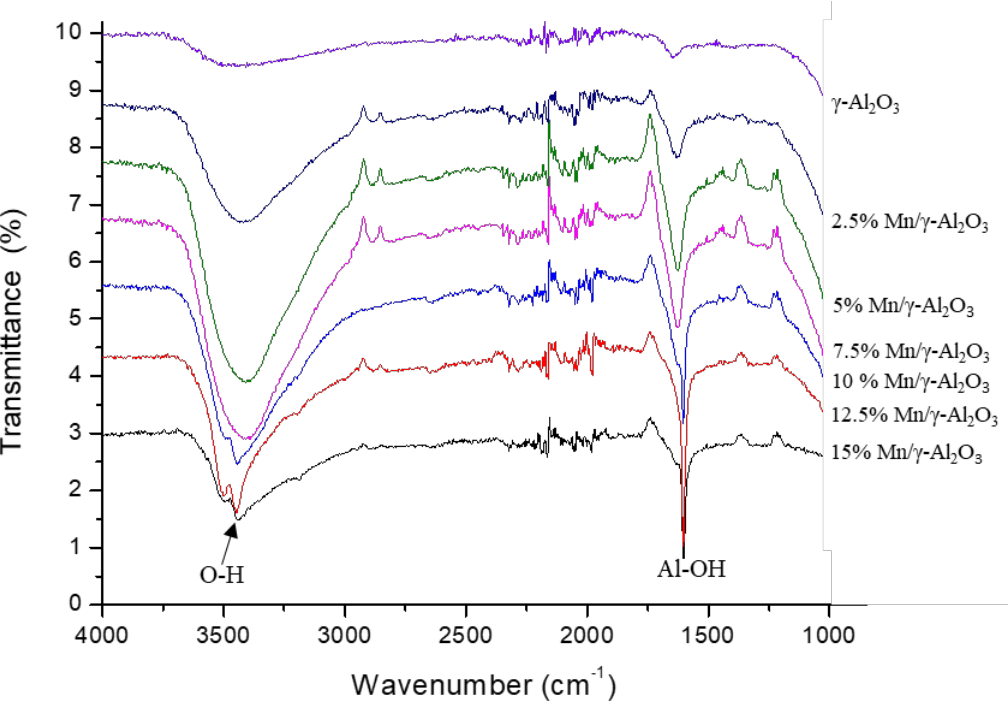
Figure 1. FT-IR spectra of γ -Al 2 O 3 and various percentages of Mn / γ -Al 2 O 3 catalysts.